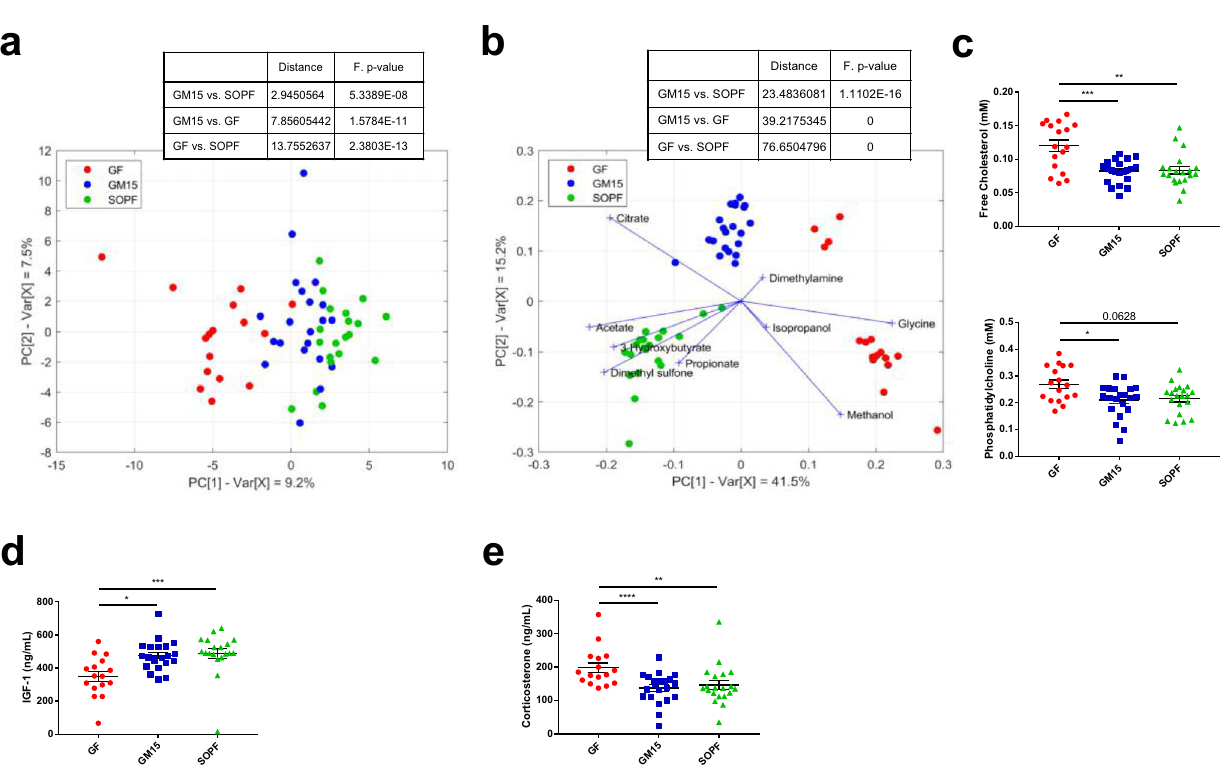
Fig. 5 Metabolic phenotyping of mice from two consecutive fi lial generations (F1 – F2). a PCA score plot representing the distribution of the polar metabolite composition along the two fi rst principal components (16 GF, 21 GM15, and 20 SOPF). b Biplot representing the projection of samples in the PLS-DA score plot given by the two fi rst components and the projection of the contribution of signi fi cant polar metabolites (16 GF, 21 GM15, and 20 SOPF). c – e Dot plots where dots, lines, and error bars represent, respectively, individual mice, means, and SEM. c F test for multiple linear regressions representing free cholesterol and phosphatidylcholine (17 GF, 21 GM15, and 20 SOPF). d Serum IGF-1 level Luminex analysis. One-way ANOVA followed by Dunn ’ s multiple comparison analysis (16 GF, 21 GM15, and 19 SOPF). e Serum corticosterone level Luminex analysis. F test for multiple linear regressions (16 GF, 21 GM15, and 20 SOPF). * P < 0.05, ** P < 0.01, *** P < 0.001, and **** P < 0.0001. Source data are provided as a Source Data fi